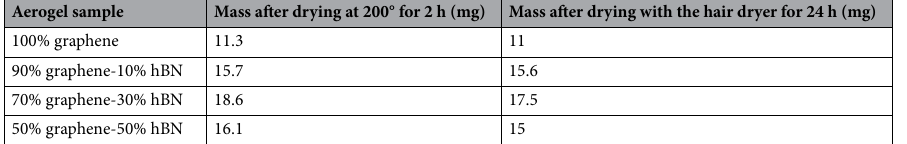
Table 3. Samples with formaldehyde.